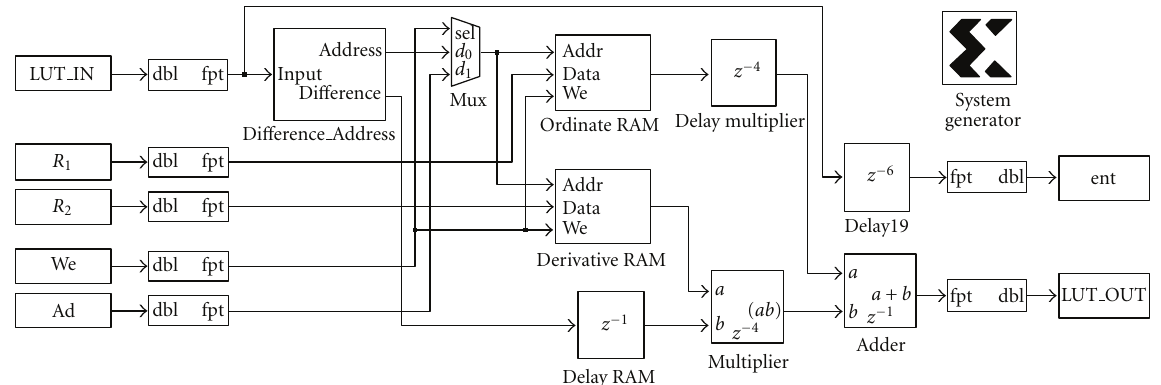
Figure 1: System generator schematic top view of the LUT-based interpolator.